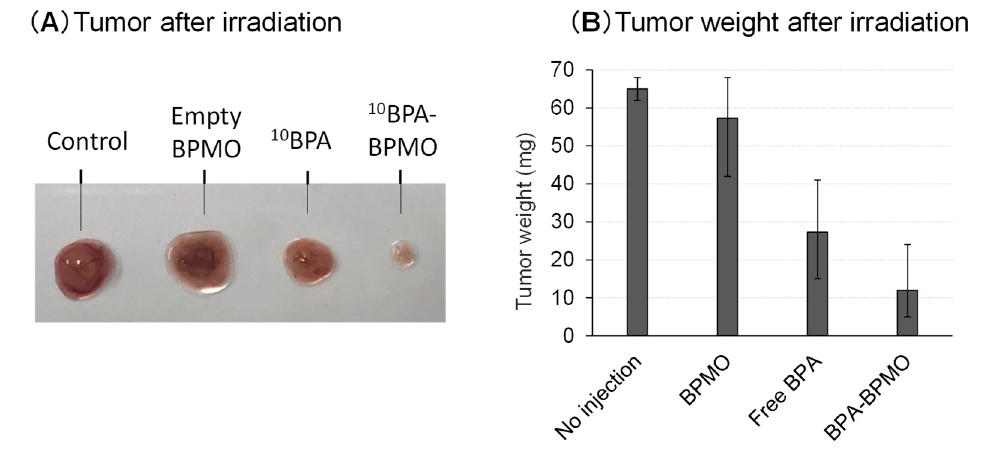
Figure 7. Tumor size after BNCT experiments. ( A ) Pictures of CAM tumors three days after neutron irradiation are shown; (B ) CAM tumors were cut out after irradiation and their weights were examined.